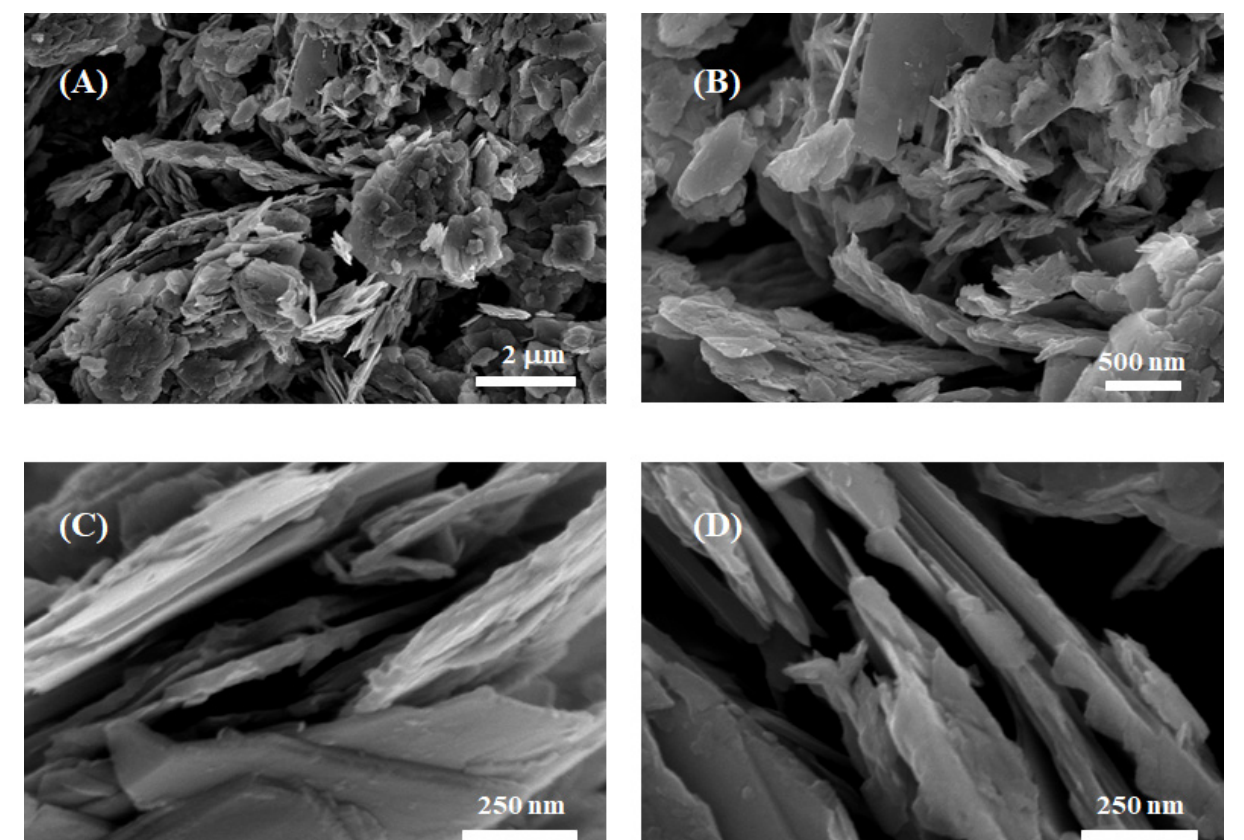
Figure 3. SEM images of the grown nanostructures: ( A ) low magnification; ( B ) medium magnification; ( C , D ) high magnification.